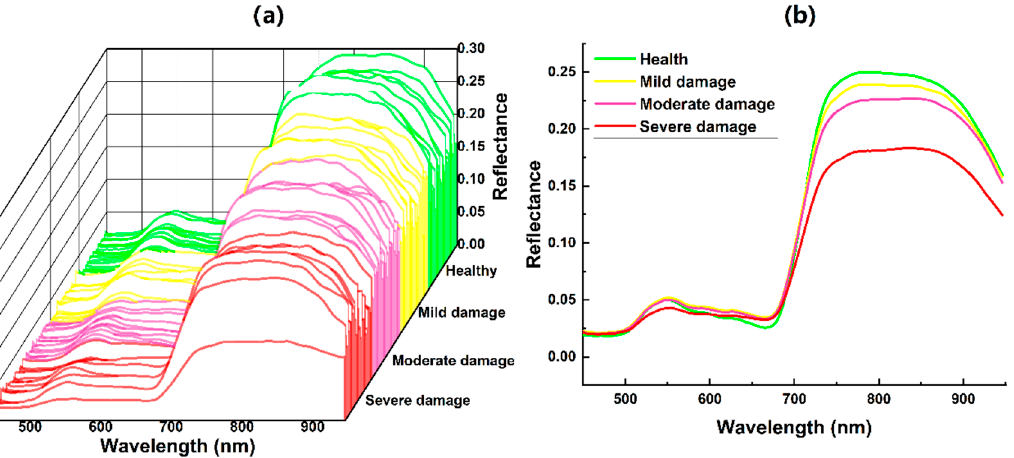
Figure S1. Spectral reflectance curves of different damage degree Pinus yunnanensis canopy by Tomicus. ( a ). the original curve, ( b ). the reflectance average curve.